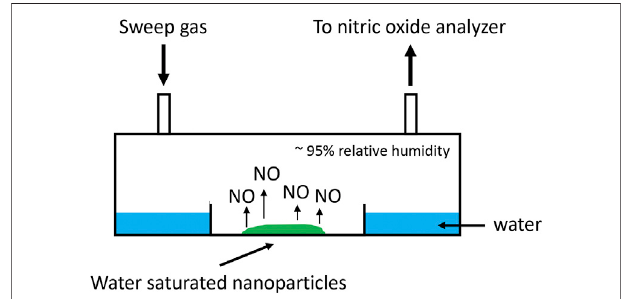
FIGURE 2 | Schematic of in vitro NO release kinetic analysis of nanoparticles. Nanoparticles saturated with deionized water released NO into